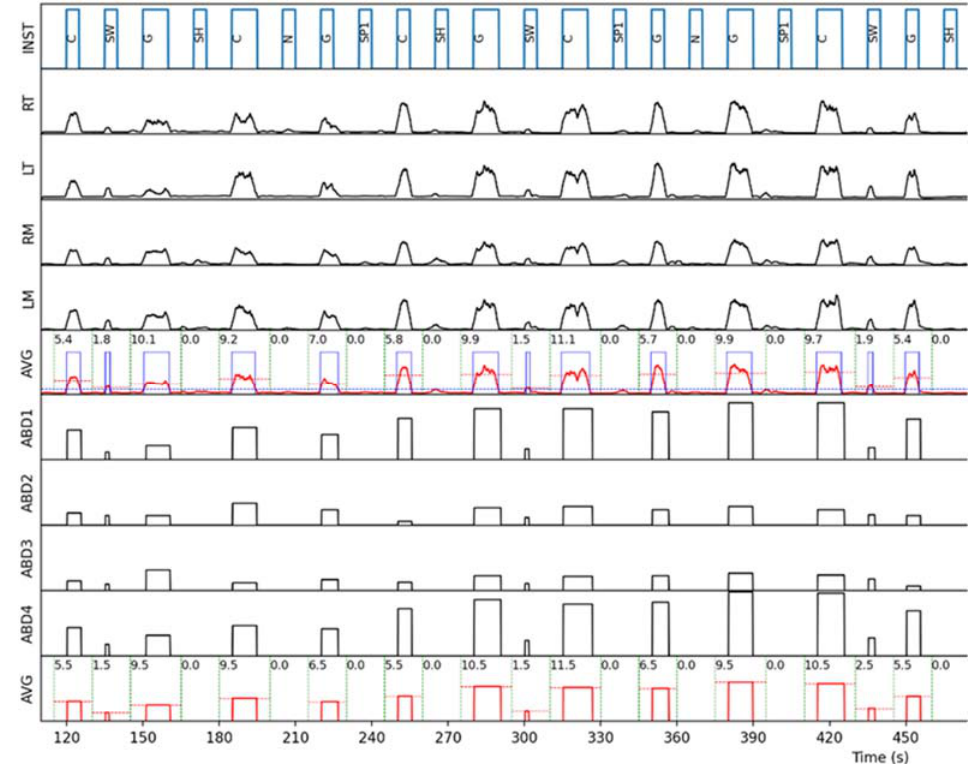
Figure 3. Partial recording of a single subject. The “INST” plot shows the instructions given to the subject: C = clench, G = grind, SW = swallow, SH = shake head, N = nod, SP1 = speak. The “RT”, “LT”, “RM” and “LM” plots show the EMG recordings (RT, LT = right and left temporalis; RM, LM = right and left masseter), and the “AVG” plot immediately underneath shows their average (red) and the automatically detected events (blue binarized signal). The “ABD1–4” plots show the mean pressure detected by each of the four sensors of the oral appliance, and the “AVG” plot immediately underneath shows their average. The numbers inside the detection window edges (delimited by the dotted green lines) represent the computed event duration, and the horizontal dashed lines show the event intensity (time average).